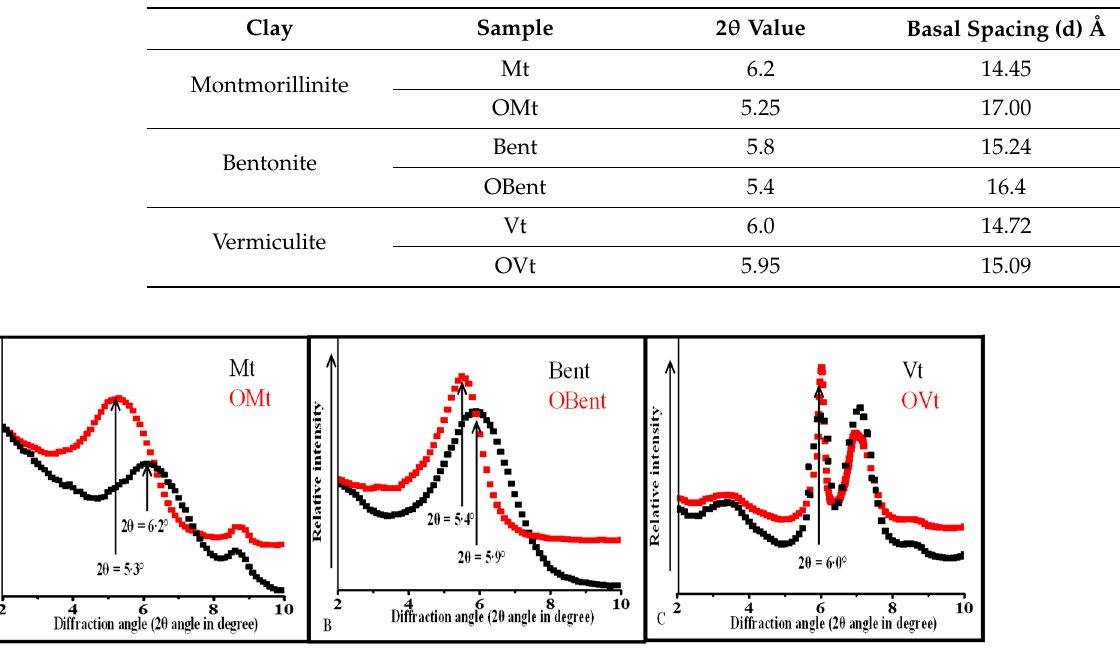
Figure 1. XRD pattern of ( A ) Mt, OMt; ( B ) Bent, OBent; ( C ) Vt, OVt.